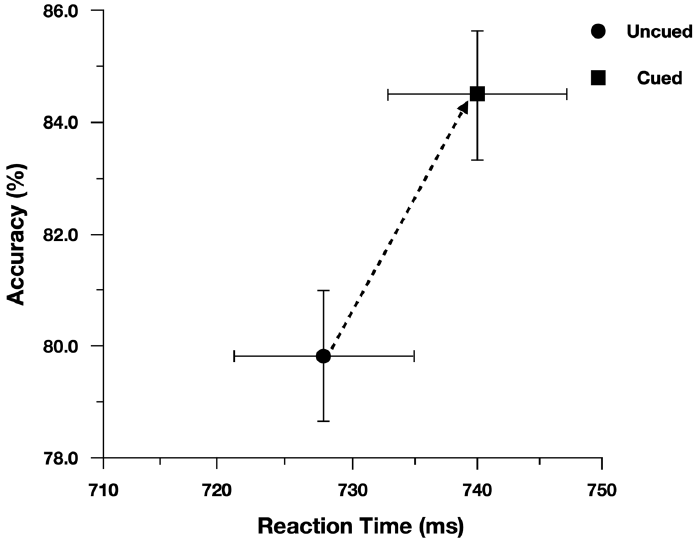
Figure 3. Overall performance for discrimination targets plotted in speed-accuracy space. Error bars represent Fisher’s least significant difference.